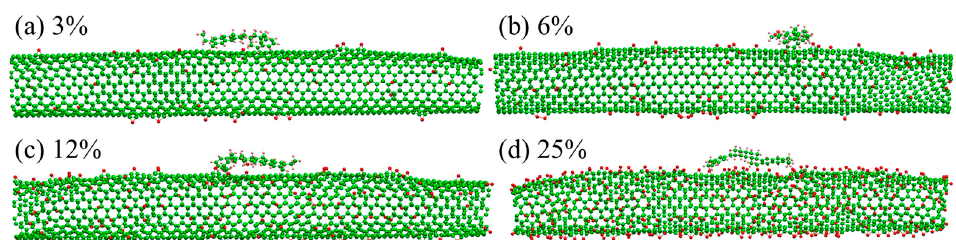
Figure 5. Molecular structure of aromatic molecule and CNTs with different oxygenated dosage of ( a ) 3%, ( b ) 6%, ( c ) 12%, and ( d ) 25%.